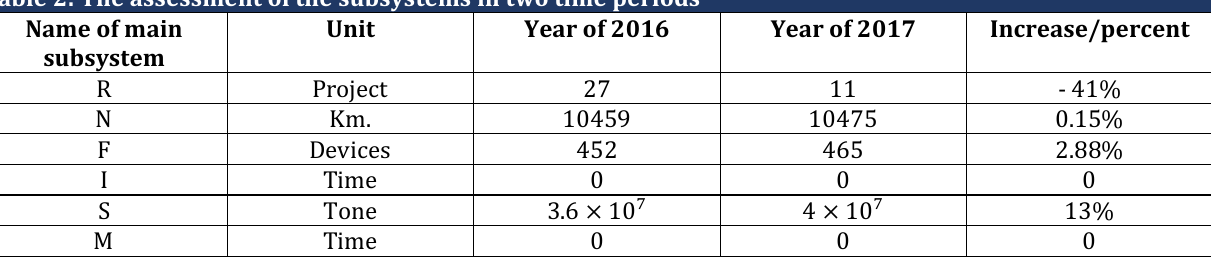
Table 2: The assessment of the subsystems in two time periods